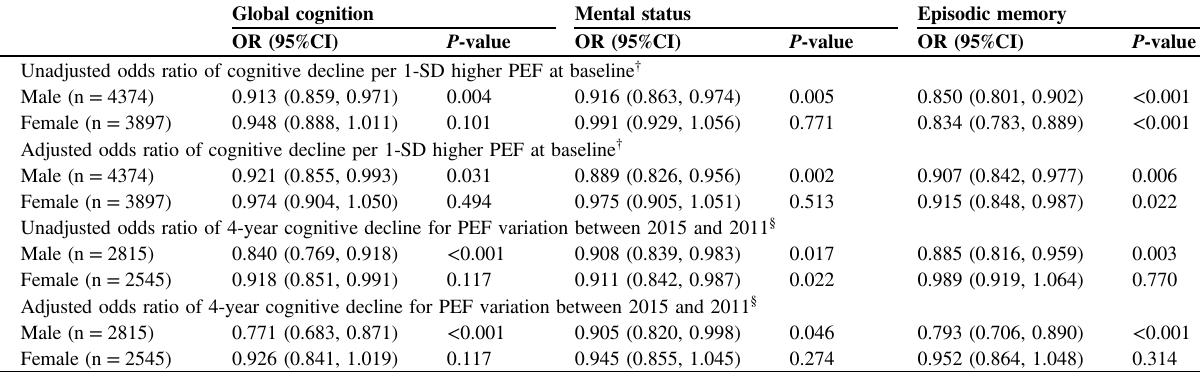
Table 3 Odds ratio of cognitive decline for PEF in participants of the